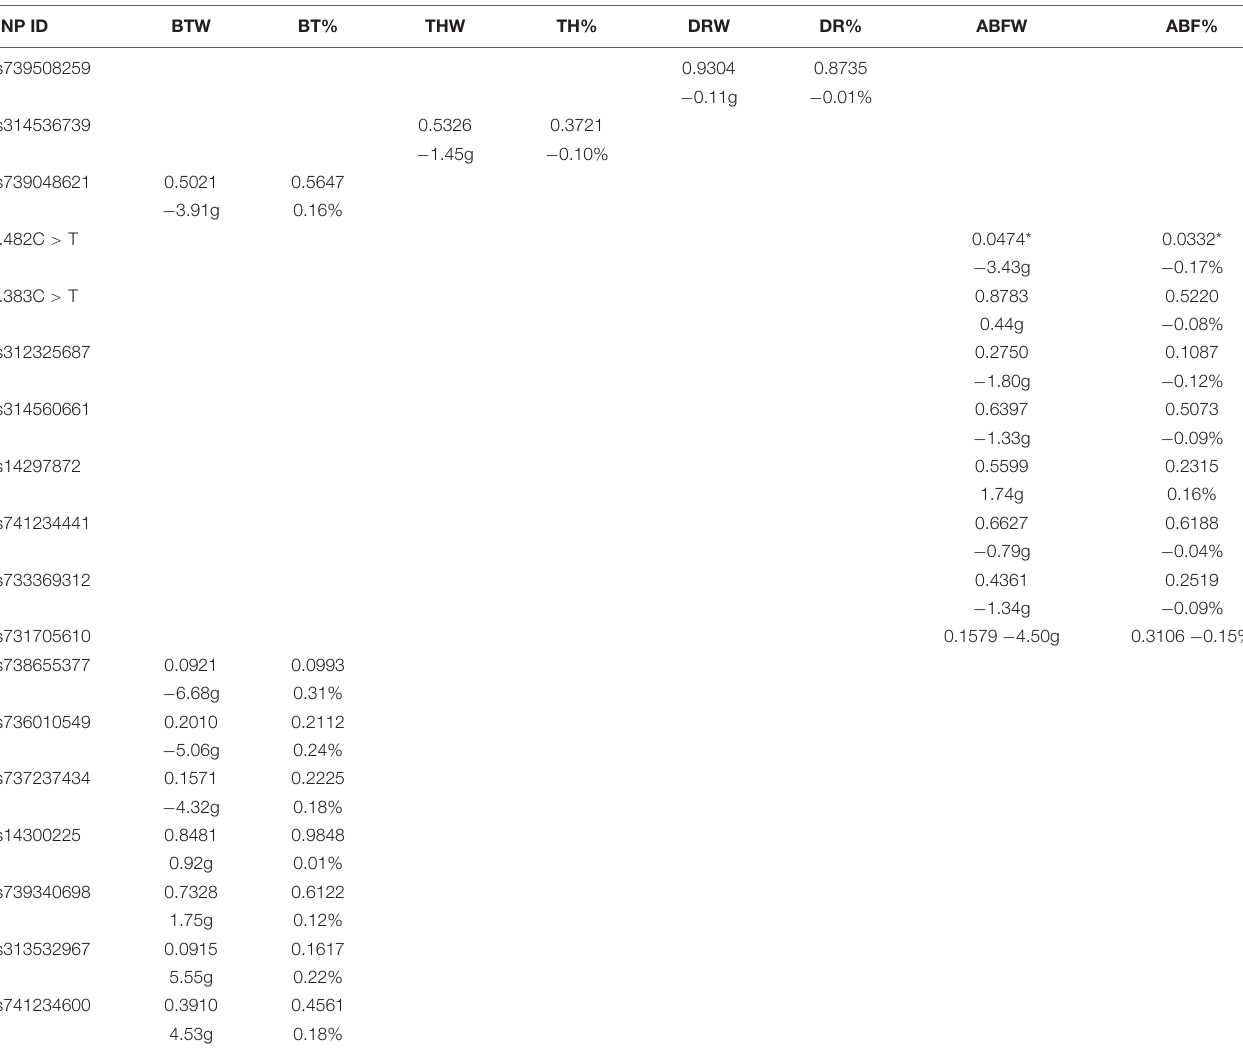
TABLE 5 | Association analysis results, p-values (upper value in cell) and effects (lower value in cell) for an additive model applied to carcass traits in the TT Reference population. SNP ID BTW